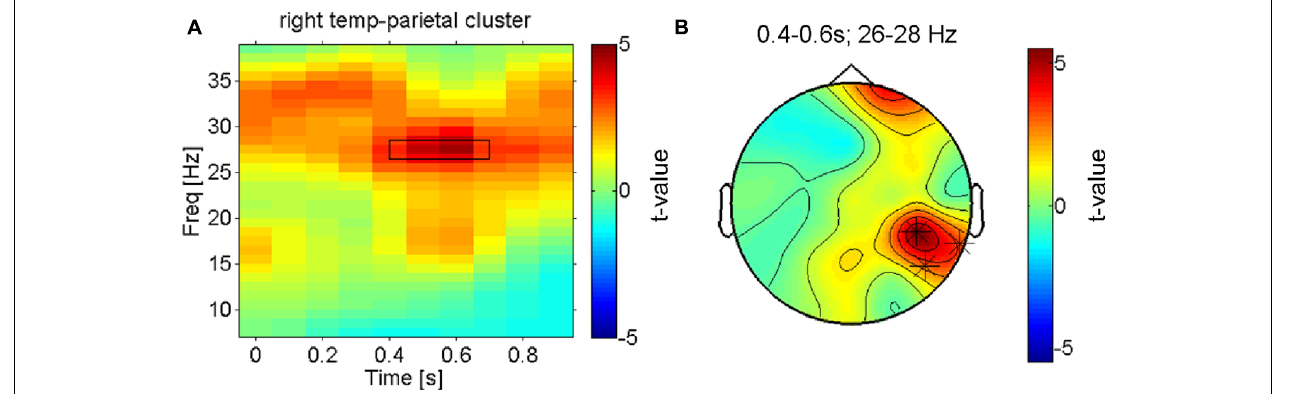
statistical comparison of preferred vs. least preferred fabrics in the significant time-frequency window (26–28 Hz, 0.35–0.65 s as marked in B ). The asterisks indicate the electrodes that form the significant cluster that survived correction for multiple comparisons. Besides these right parietal electrodes, a right frontal electrode is also strongly modulated (n.s. when corrected).